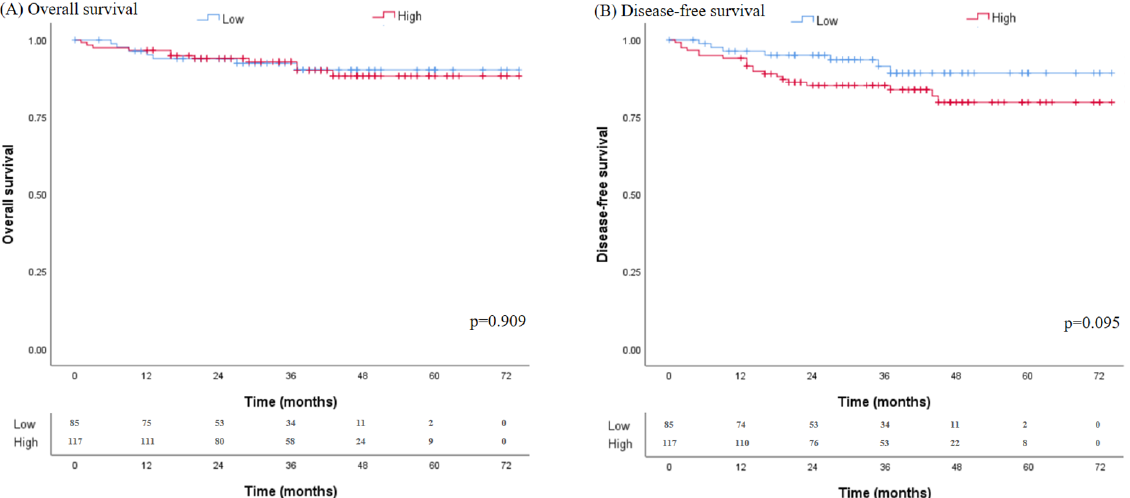
Figure 4. Kaplan–Meier survival curve for the cumulative risk of recurrence. Kaplan–Meier survival curve showed better overall survival ( p = 0.909) and disease-free survival ( p = 0.095) without significant difference in patients with low visceral fat area, respectively.